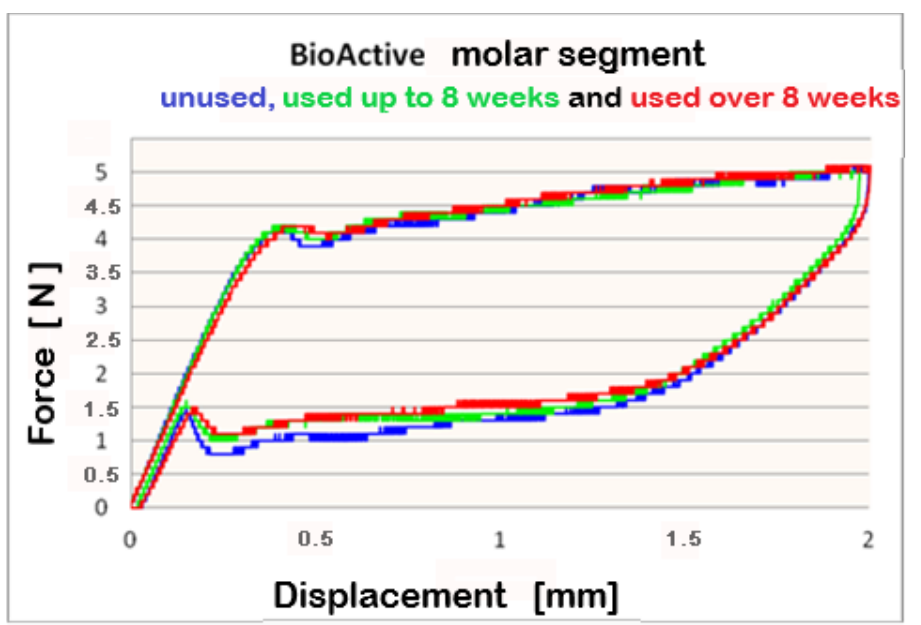
Figure 4. Combined force/deformation curve graphs for period G 0 (blue), G 1 (green) , G 2 (red), molar segment for the Bio-Active ® archwire.